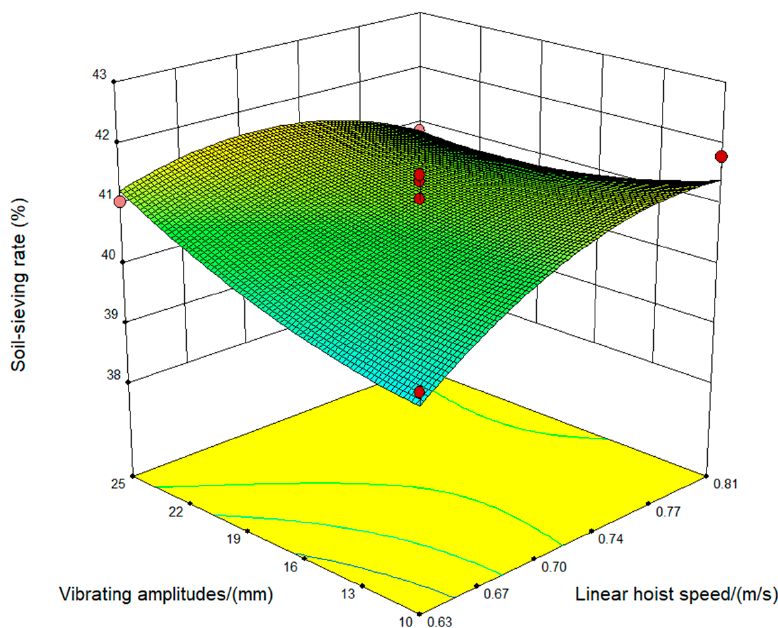
Figure 10. Response surface diagram of vibration amplitude and linear hoist velocity.